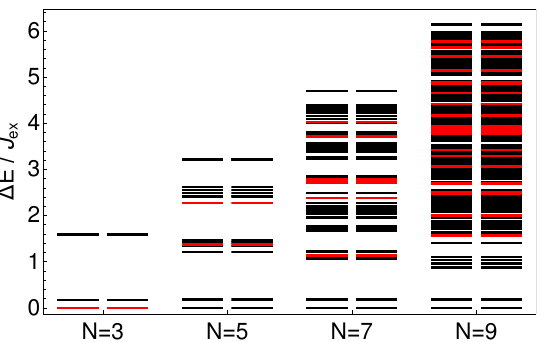
Figure 5. Energy levels for N = 3-, 5-, 7- and 9-membered antiferromagnetically coupled Heisenberg rings with J ex = 10 D DM . Degenerate levels that support toroidal moments are labelled in red, whilst those that do not are labelled in black. Note that only for N = 3 are toroidal moments present in the ground